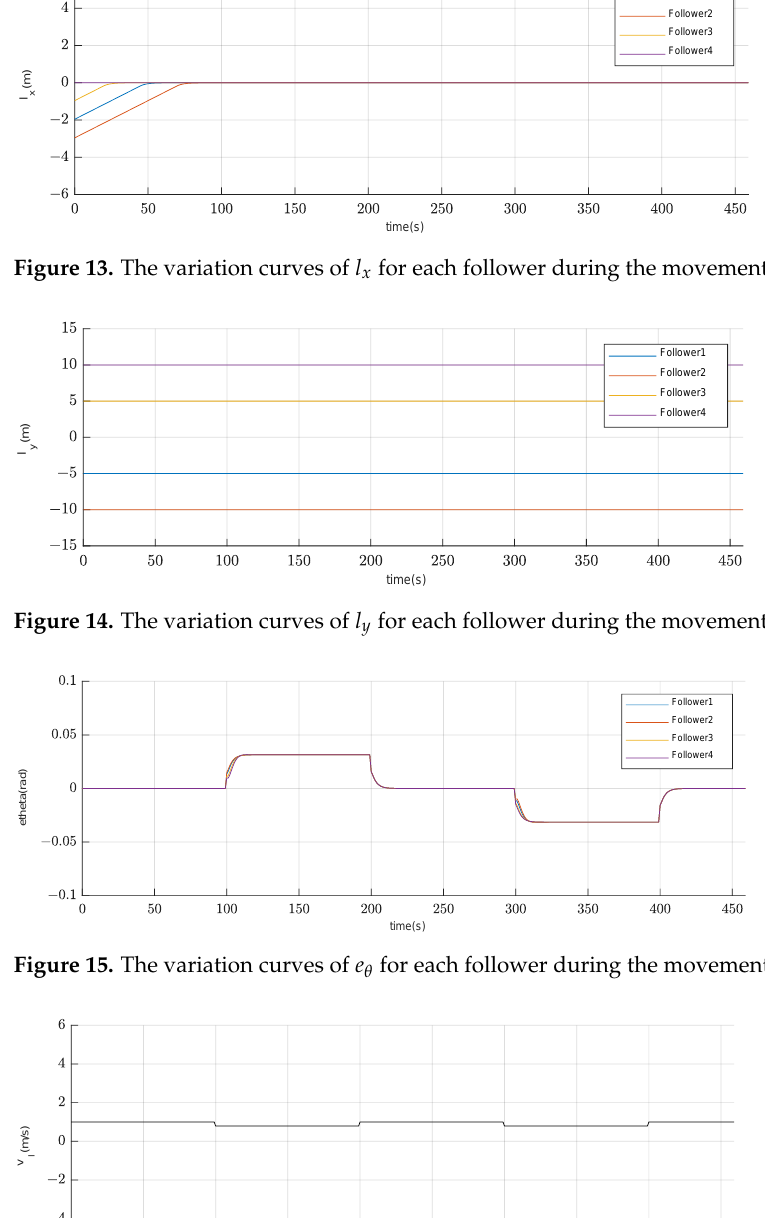
Figure 16. The variation curve of v l for the leader during the movement.